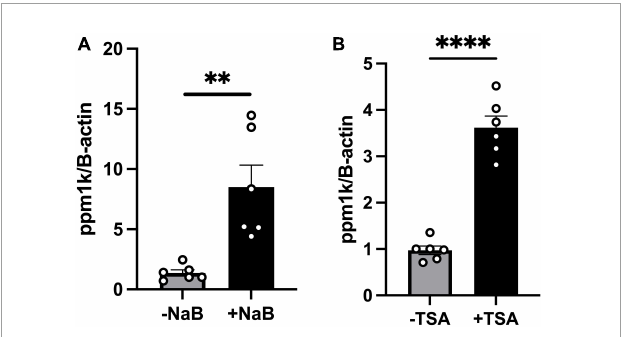
FIGURE5 Tributyrin upregulation of ppm1k occurs at least in part through HDAC inhibition. (A) mRNA levels of ppm1k in C2C12 treated with 5mM sodium butyrate (NaB) or vehicle. (B) mRNA levels of ppm1k in C2C12 cells treated with 1 µ M HDAC inhibitor Trichostatin A (TSA) or vehicle. Statistical analysis was done using unpaired student’s t -test. Data are mean ± S.E.M. ( ∗∗ p < 0.005, ∗∗∗ p < 0.0005, and ∗∗∗∗ p < 0.00005), ( n = 6 per